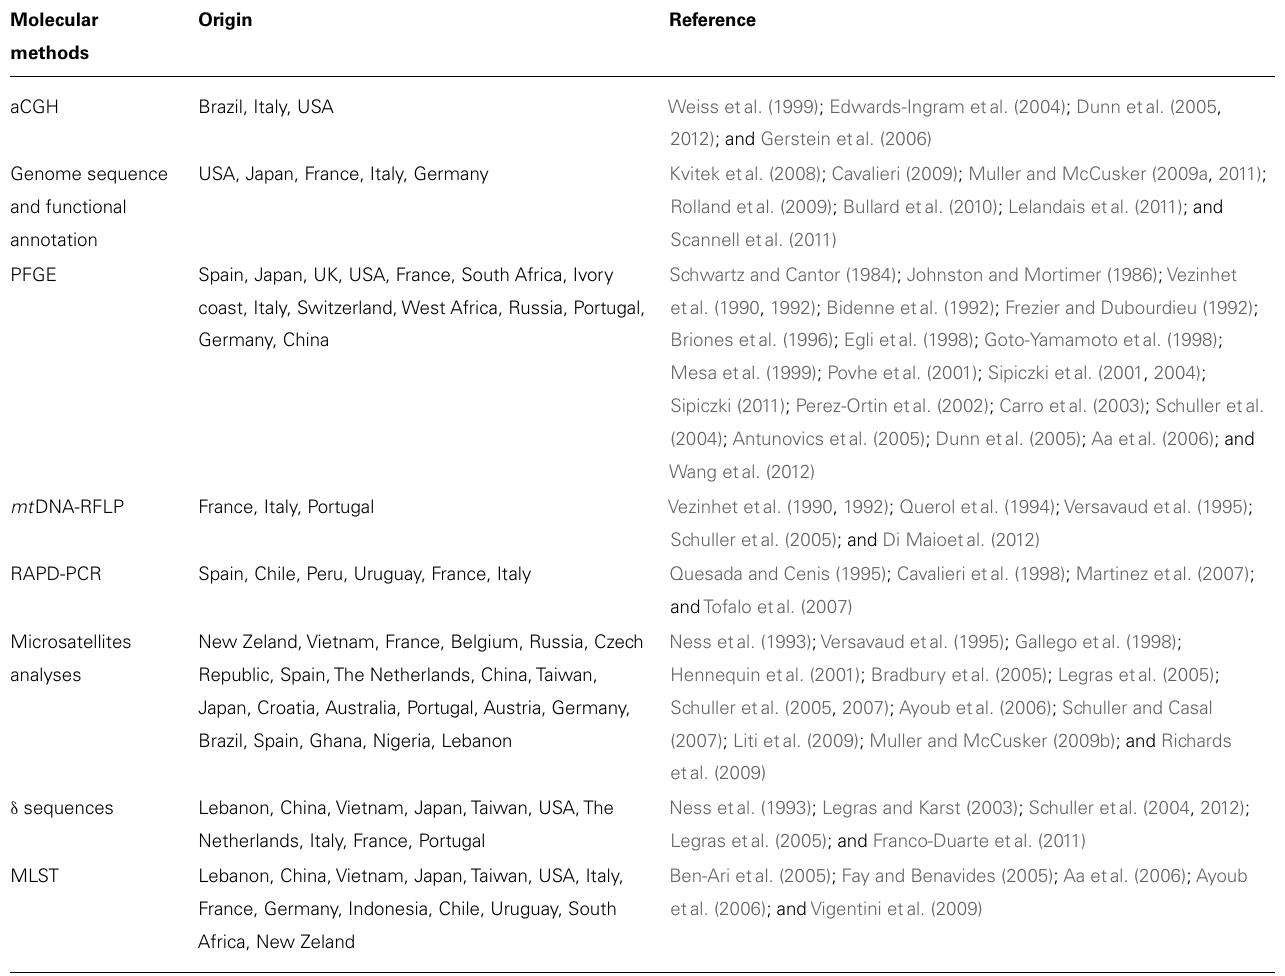
Table 3 | Molecular approaches used for S . cerevisiae biogeographical